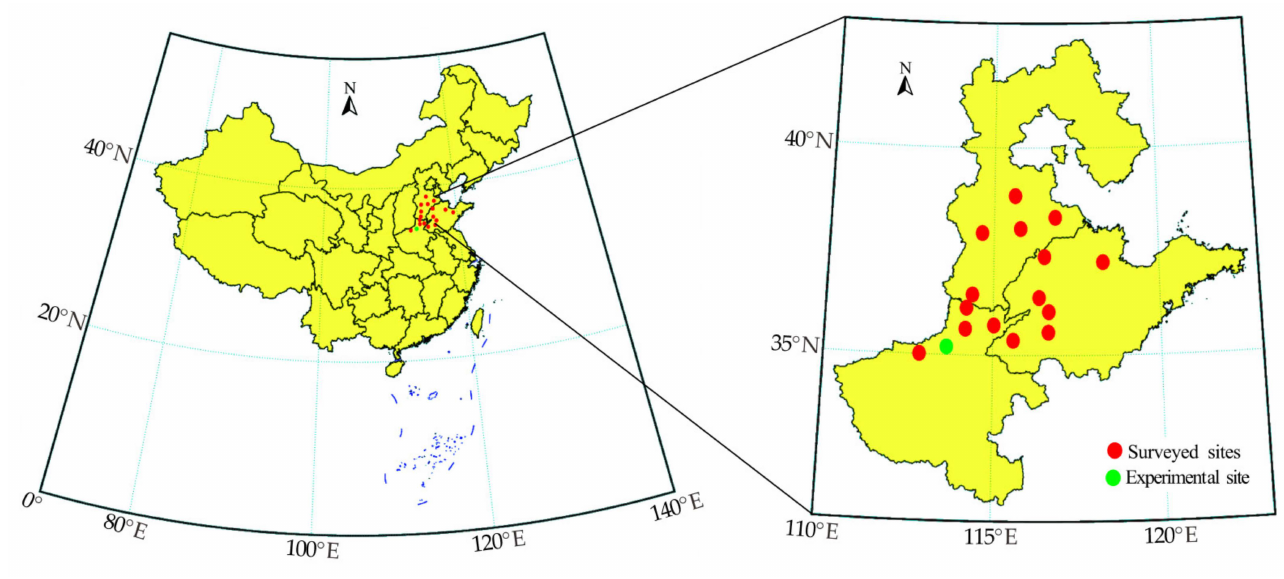
Figure 1. Location of surveyed sites and experimental site in the